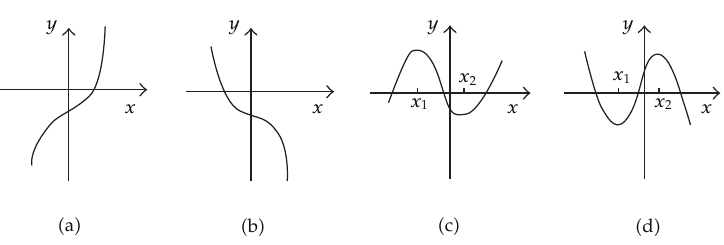
Figure 1: The four forms of cubic function